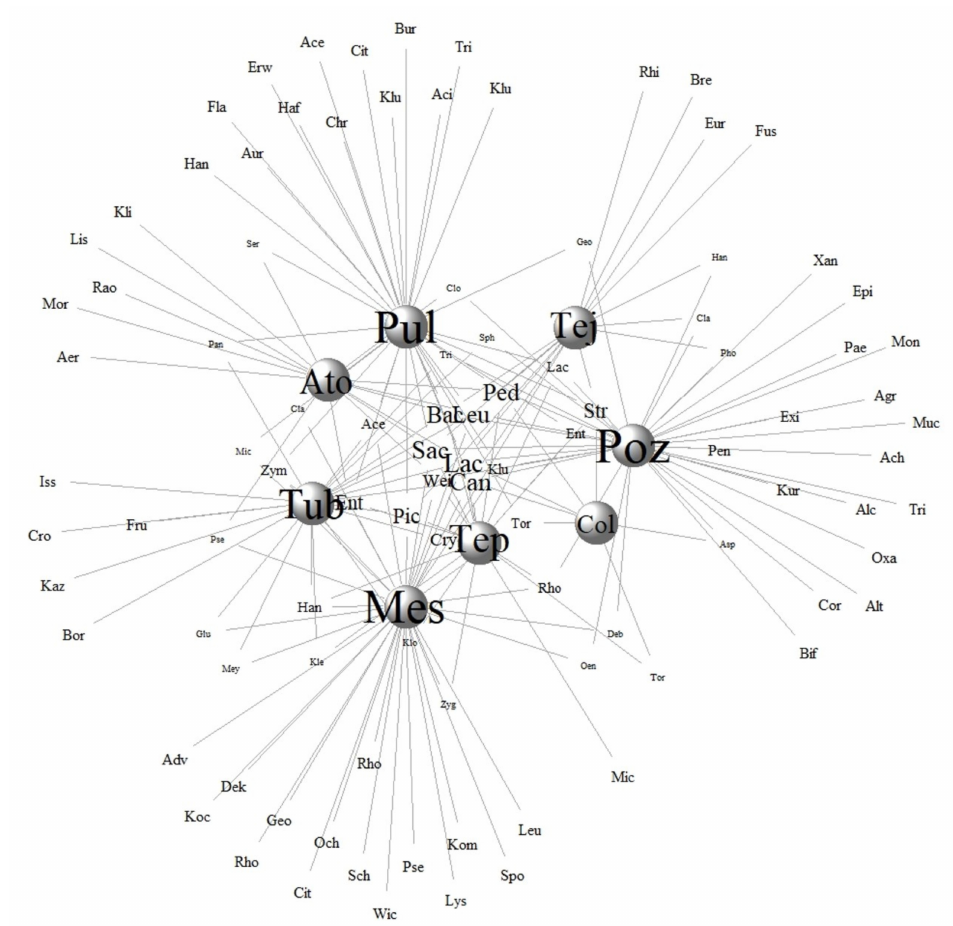
Figure 3. Network of microorganisms. Grey circles represent the names of the TMFB, Tep is for tepache, Col is for colonche , Mes is mescal , Ato for atole agr í o , Pul for pulque , Tub for tuba , and Tej for tejuino. The size of the letters represents the number of microorganisms recorded for each beverage. The letters in the middle represent the microorganisms that are shared commonly in the studied beverages. Saccharomyces (Sac), Lactobacillus (Lac), and Candida (Can), among others, are common shared microorganisms. Mescal , pulque , and pozol are the most studied beverages in which a major group of microorganisms has been recorded. Colonche displays the lowest connectivity due to the few studies on this beverage. The genera of microorganisms and the names of beverages are displayed in the Table